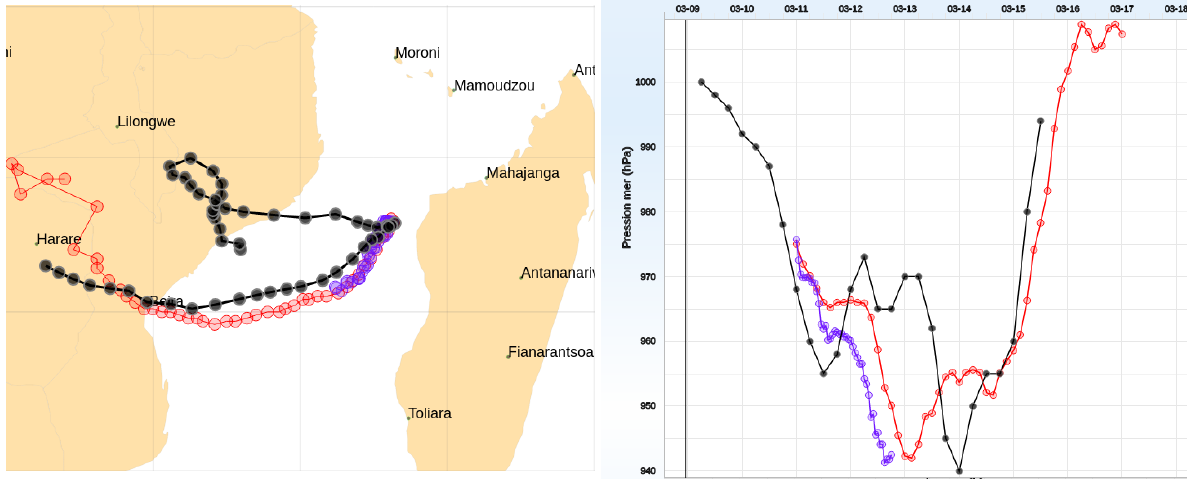
Figure 20. Trajectory ( left ) and evolution of MSLP ( right ) for TC IDAI from 5 to 16 February 2019. BT analyses (black), 42-h lead time forecasts starting from 11 March 00:00Z for operational AROME-OI model (purple) and 144-h lead time forecasts starting from 11 March 00:00Z for operational IFS model.